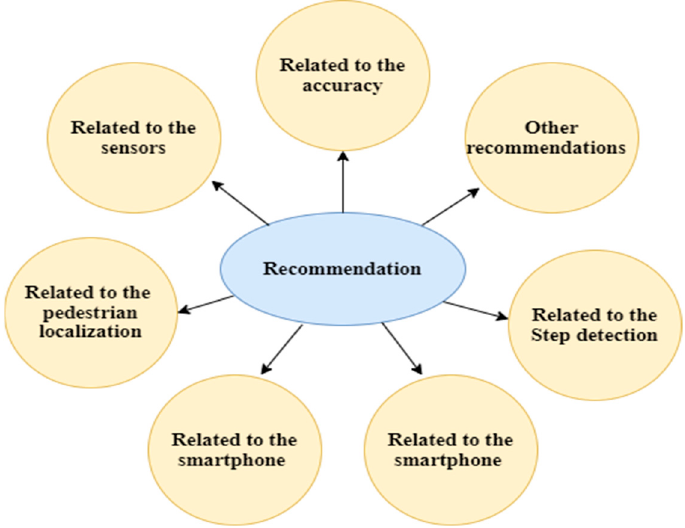
Figure 7. Overview of recommendations.